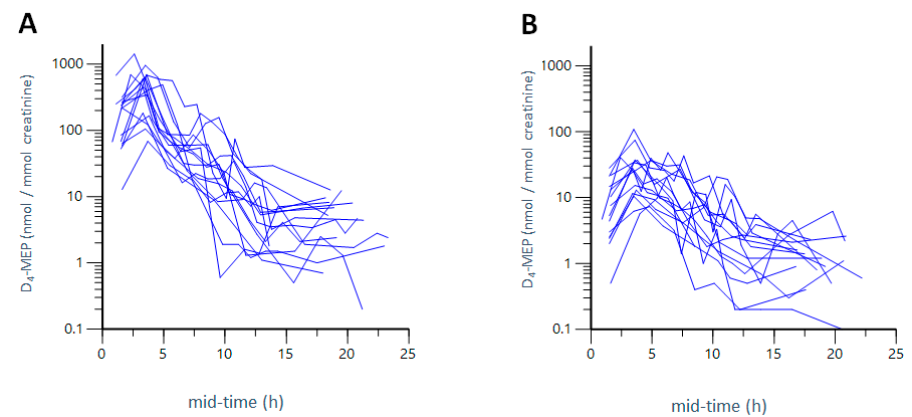
Figure 2. Excretion kinetics of D 4 -MEP. Excretion of the urinary metabolite D 4 -MEP from 16 participants over mid-time (mid time point of collection interval) after combined inhalation and dermal exposure to D 4 -DEP ( A ) and dermal only exposure to D 4 -DEP ( B ). The y-axis is presented in a logarithmic scale, and time points are given in mid-time (mid time point of collection interval). For the combined inhalation and dermal, exposure to D 4 -DEP, T max for D 4 -MEP was calculated as 3.3 h and T½ as 2.1 h (average over all participants). The maximum metabolite concentration (C max ) was measured as 513 nmol/mmol creatinine of excreted metabolite in urine per mmol creatinine (AUC of 1642 nmol·h/mmol creatinine) (Table 1 ) .